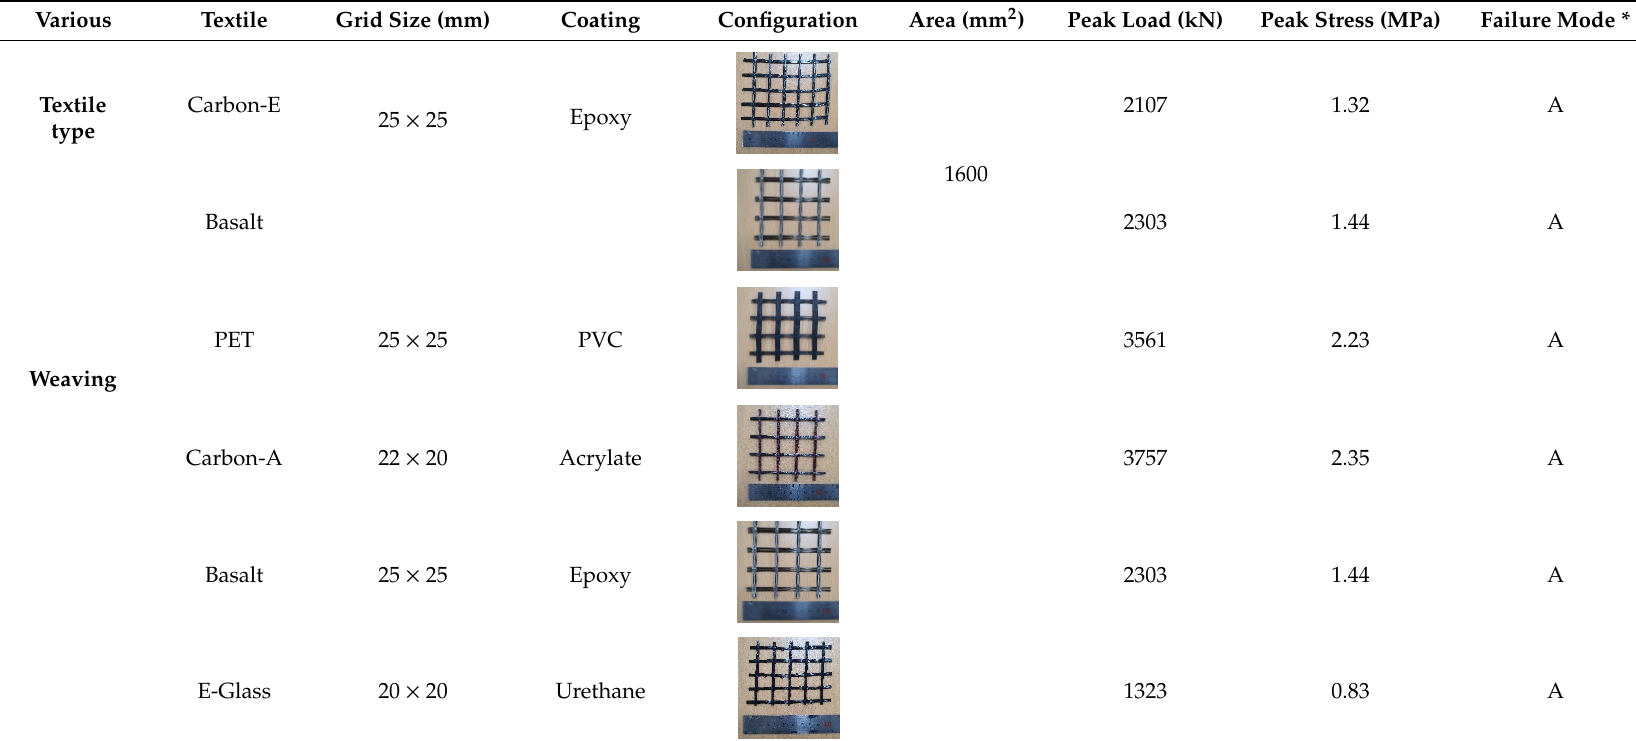
Table 7. Properties of pull-o ff specimens and test